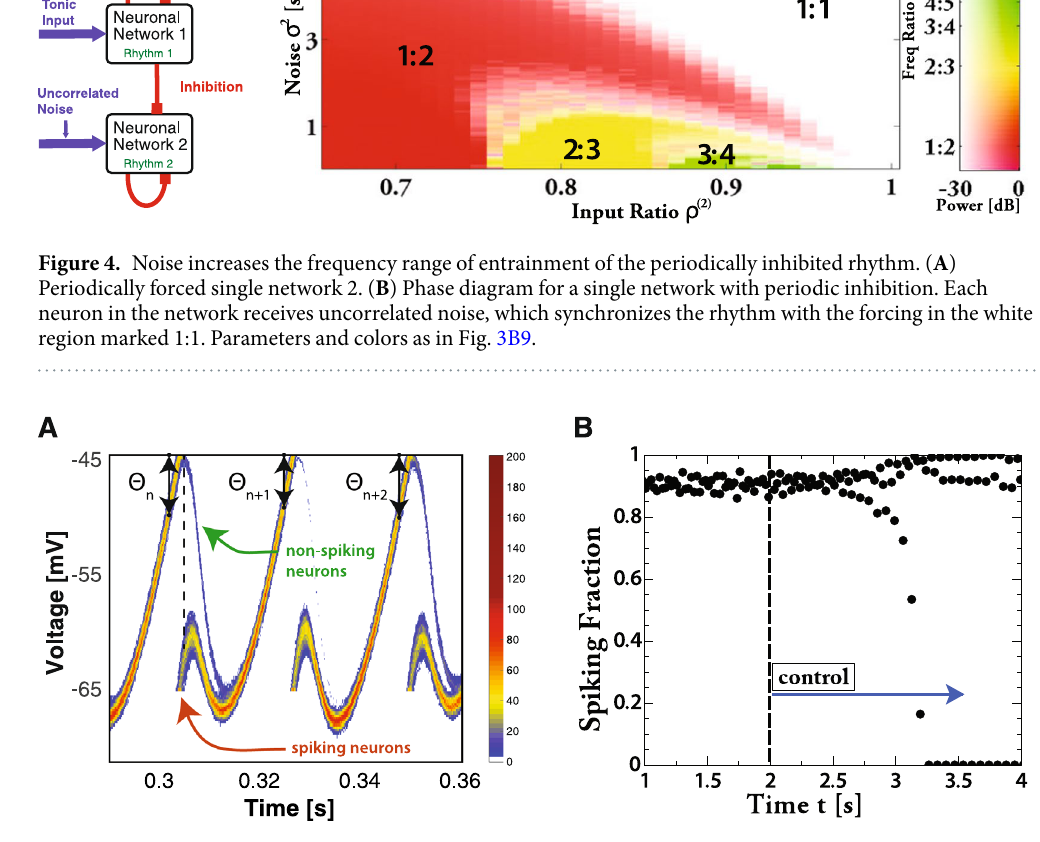
where f is the time average of f spiking ( t ) before the control is turned on. Indeed, synchronization is lost when spiking this control is applied, as is apparent from the resulting strongly varying spiking fraction (Fig. 5B). Period-Doubling. The phase diagrams shown in Figs 3 and 4 suggest that in this parameter regime synchro- nization is reached via a continuous period-doubling bifurcation. To confirm this explicitly for the single network with periodic forcing (Fig. 4), we extract from the simulations an iterated map for the lag θ ≡ − θ V where V (2) is the LFP of network 2 and t n is the time when neurons in network 1 spike in the n th cycle; the θ n are marked by double arrows in Fig. 5. For small noise ( σ 2 = 0.05 s − 1 ) the iterates of θ n trace out an almost continuous noisy attractor, corresponding to irregular dynamics (Fig. 6). When the noise is increased to σ 2 = 0.2 s − 1 , this attractor changes to two domains, corresponding to a noisy 2-cycle. With a further increase in the noise ( σ 2 = 0.6 s − 1 ) the two domains merge to a single, noisy fixed point that corresponds to the synchronized state. Conversely, when the noise is decreased, the synchronous state becomes unstable via a period-doubling bifurca- tion. In view of Fig. 5 this instability can be understood intuitively by noting that for weak noise the voltage dis- tribution of the neurons is narrow and even small changes in the timing of network 2 strongly affect its fraction f spiking of spiking neurons, resulting in a large gain in the feedback via self-inhibition. If that gain is too large, i.e. if the voltage distribution is too narrow, the feedback destabilizes the fixed point via a period-doubling bifurcation. This central role of the noise-induced heterogeneity in the voltage can be condensed into a simple, heuristic map model (cf. Supplementary Information, Fig. S3). Thus, desynchronization of the neurons within a network can enhance the synchronizability of the collective oscillation of a network with externally applied periodic inhibition or with the inhibition provided by rhythms in other networks.